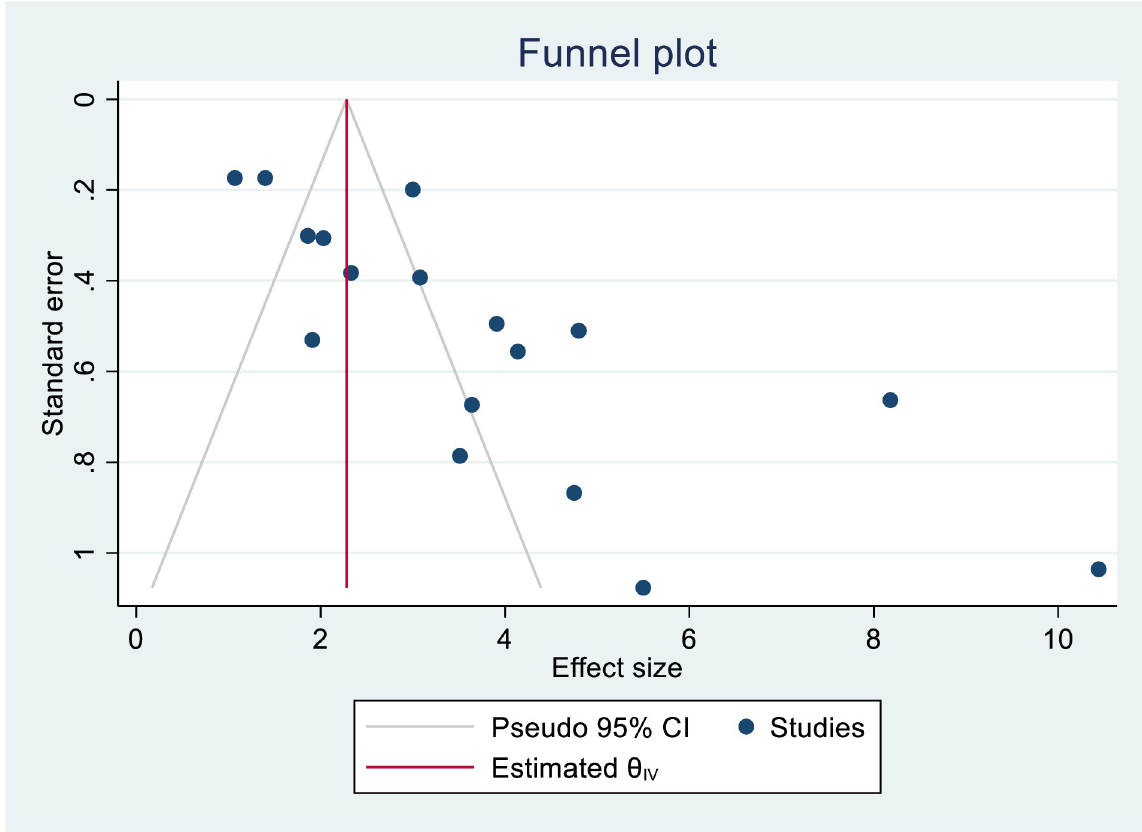
Fig 5. Funnel plot showing publication bias among studies used to compute the incidence density rate of mortality in patients with drug- resistant tuberculosis.